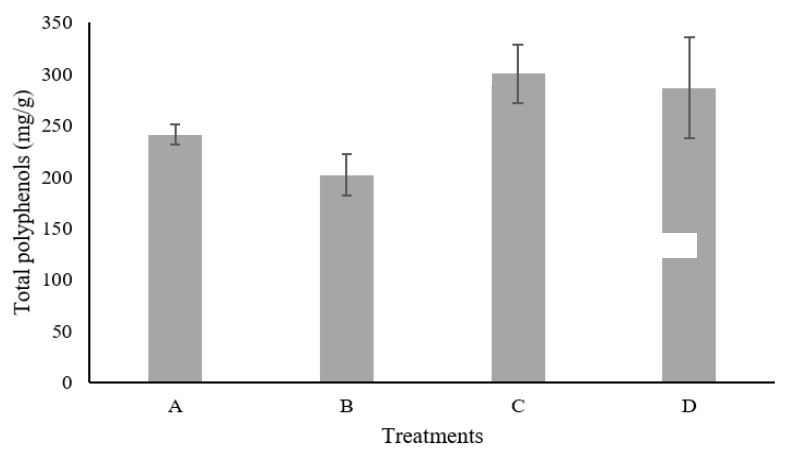
Figure 3. Extraction of total polyphenols by fermentation of Castilla Rose using Aspergillus niger (25 ◦ C, 2 × 10 6 esp / g); B (30 ◦ C, 2 × 10 6 esp / g); C (25 ◦ C, 2 × 10 7 esp / g); D (30 ◦ C, 2 × 10 7 esp / g). GH1.A (25 °C, 2 × 10 6 esp/g); B (30 °C, 2 × 10 6 esp/g); C (25 °C, 2 × 10 7 esp/g); D (30 °C, 2 × 10 7 esp/g).